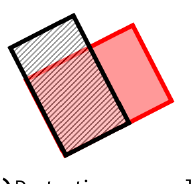
Figure 5. Cases for evaluation of building detection at area